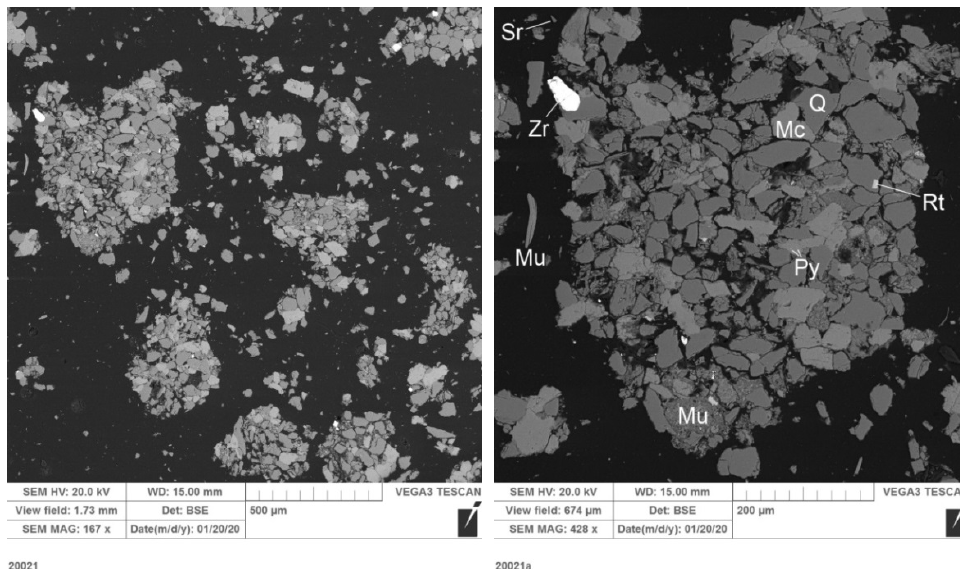
Figure A1. SEM micrograph of Sample GGS2-11-1.